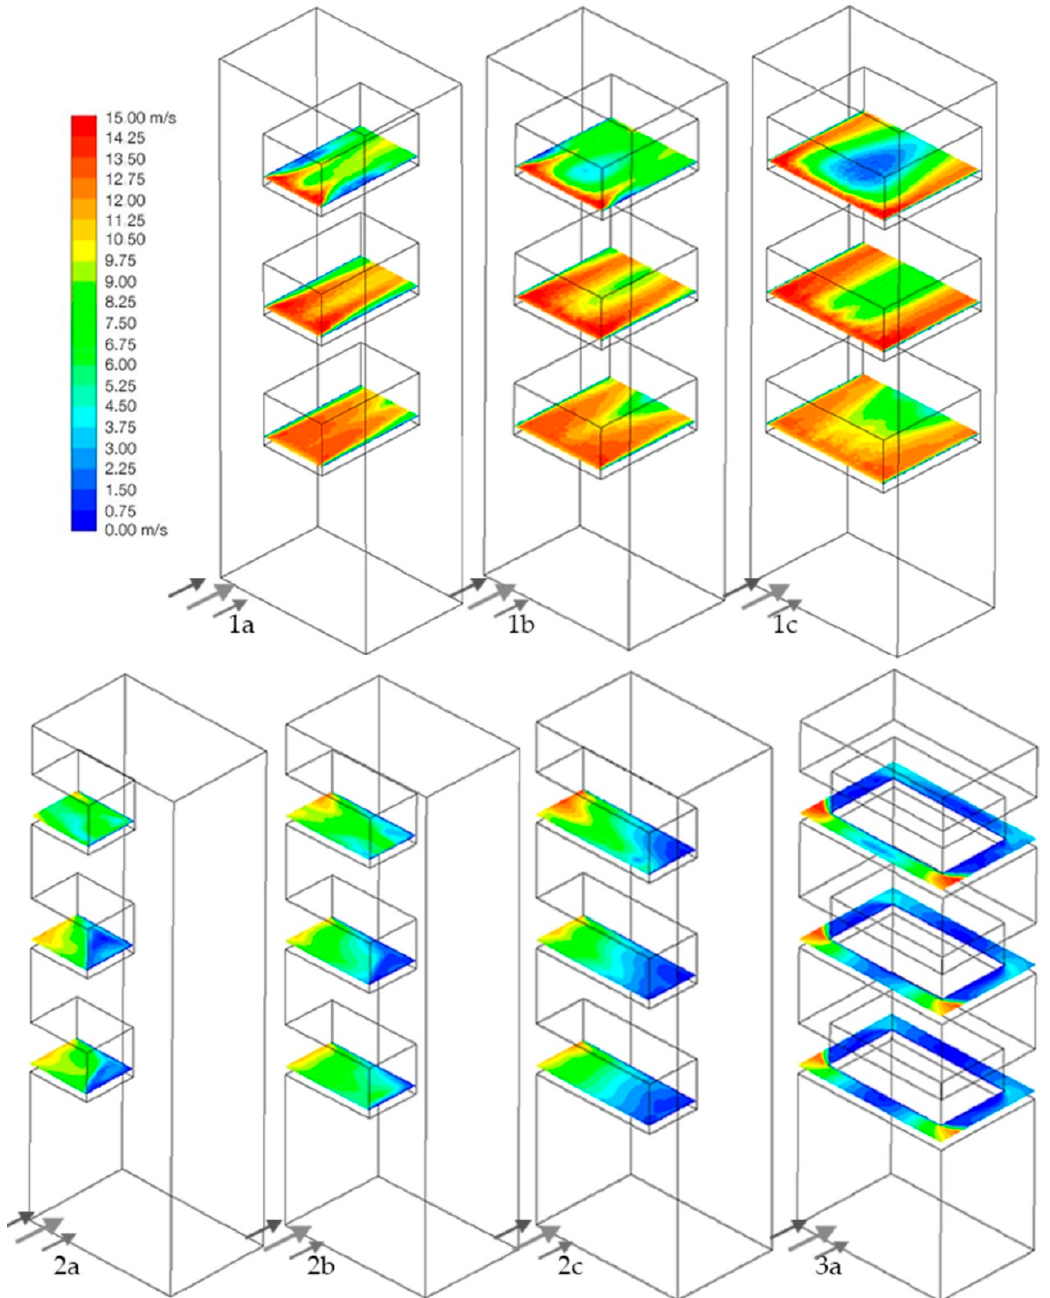
Figure 8. Velocity contours at different heights for different sky garden configurations; (1a) Central sky garden b/B = 0.4, (1b) Central sky garden b/B = 0.6, (1c) Central sky garden b/B = 0.8, (2a) Corner sky garden b/B = 0.4, (2b) Corner sky garden b/B = 0.6, (2c) Corner sky garden b/B = 0.8, (3a) Periphery sky garden a/A = 0.5.